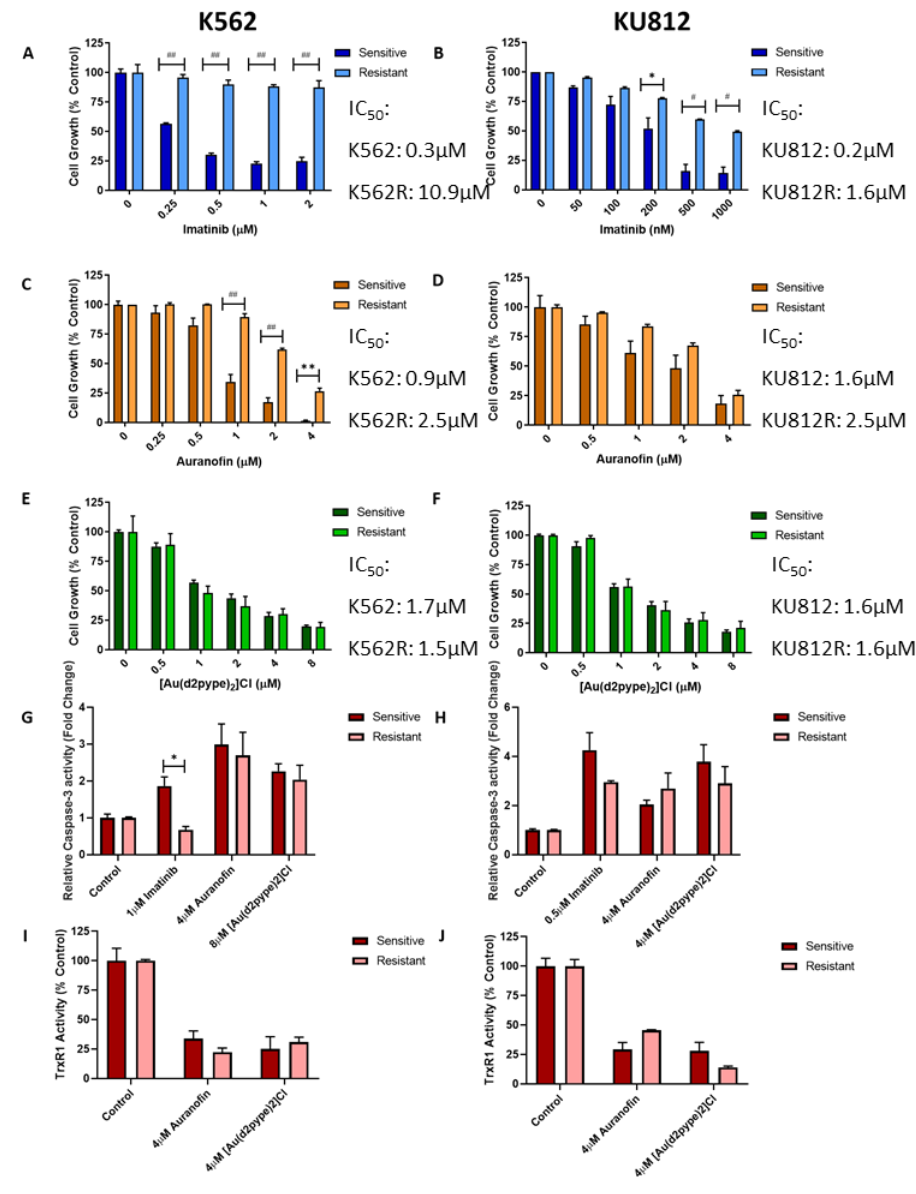
Figure 6. Imatinib Resistant CML cells are susceptible to TrxR Inhibitors. A – F : Sensitive and resistant K562 and KU812 cells were treated with either imatinib ( A , B ), auranofin ( C , D ) or [Au(d2pype) 2 ]Cl ( E , F ) for 48h. Following all these treatment times MTT proliferation assays were performed. G , H : Caspase-3 activity assays were performed on sensitive and resistant K562 and KU812 cells after 24 h treatment of either imatinib, auranofin or [Au(d2pype) 2 ]Cl. I , J : TrxR activity assays were performed on sensitive and resistant K562 and KU812 cells after 24 h treatment of either auranofin or [Au(d2pype) 2 ]Cl. Results were analysed via two-way ANOVAs with a Dunnett’s post hoc test. Statistical tests compared results between the sensitive and resistant cell lines. * = p < 0.05, ** = p < 0.01, # = p < 0.001, ## = p < 0.0001. N = 3. Values displayed as mean ± SEM.